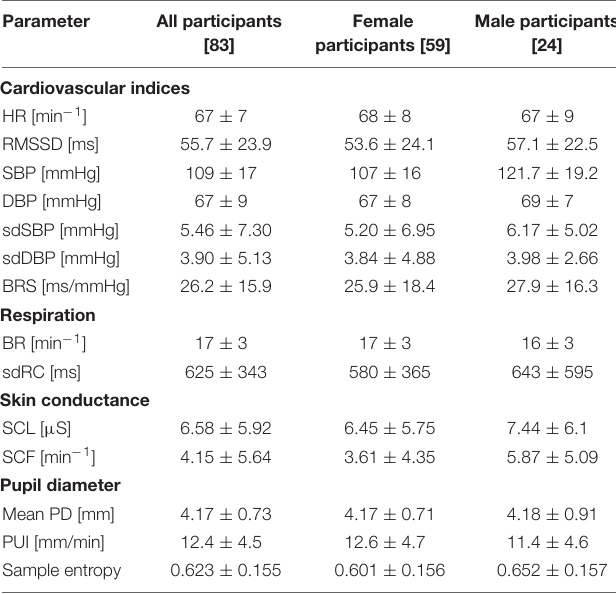
TABLE 3 | Indices of the cardiovascular system, respiration, skin conductance, and pupil size. Parameter